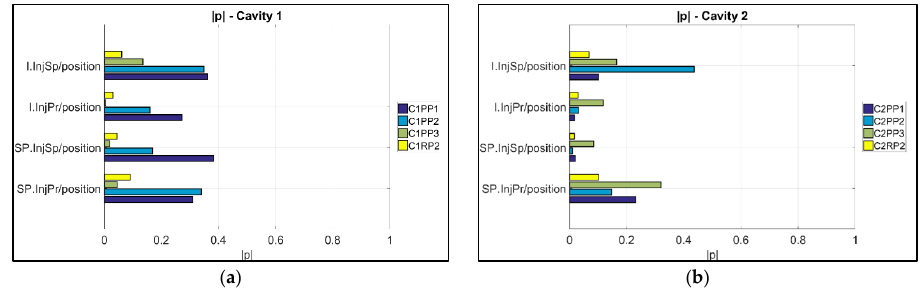
Figure 18. Pearson correlation coefficient plots of measurands to the pillar “product fingerprint” positioned on the runner of the molding ( a ) in Cavity 1 and ( b ) in Cavity